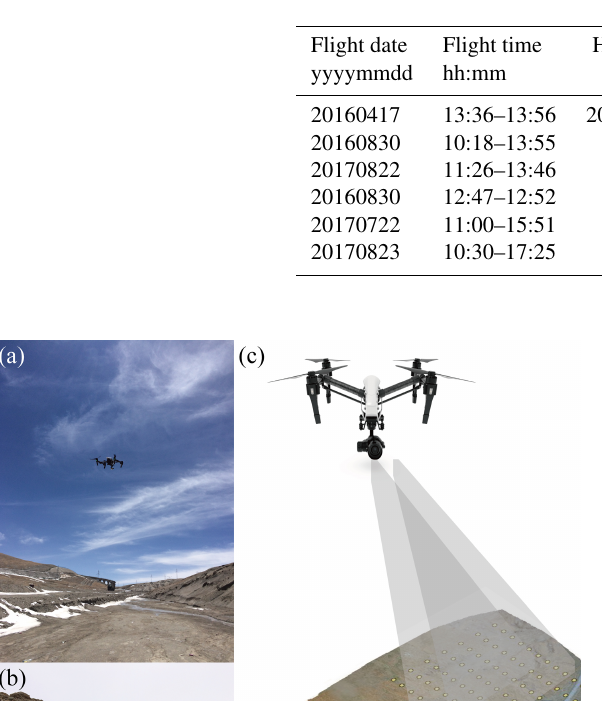
Table 2. UAV flight time from 2016 to 2017.